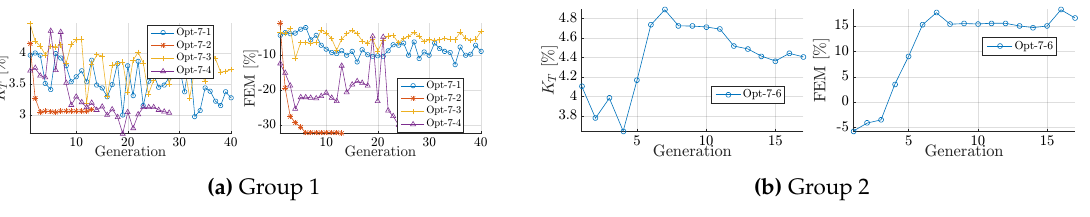
Figure 30. Development of objectives, given as median of relative improvements per